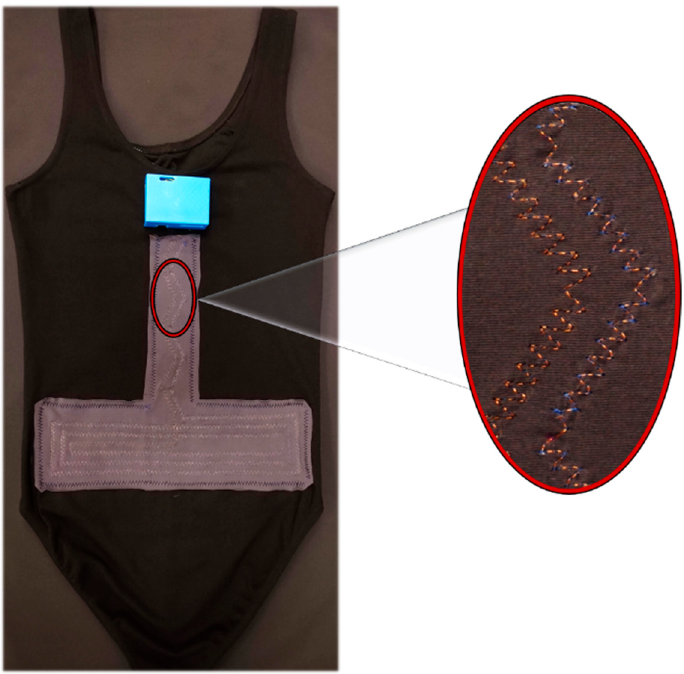
Figure 6. Smart garment prototype. Rear view of the smart garment with the inductive sensor affixed to the part that goes on the lumbar section.